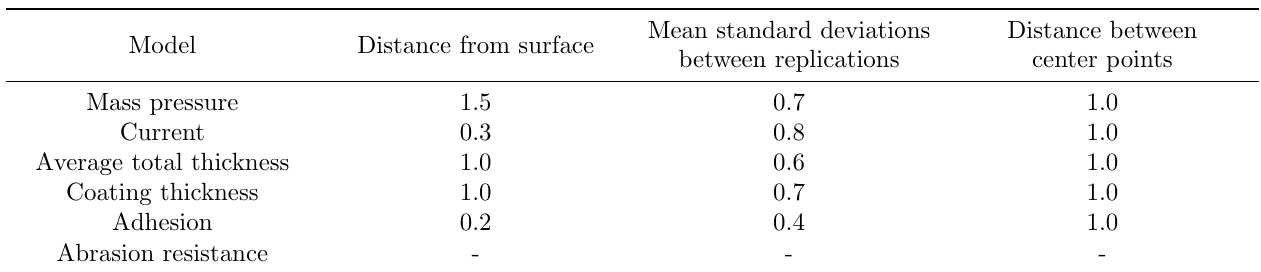
Table 4: Surface